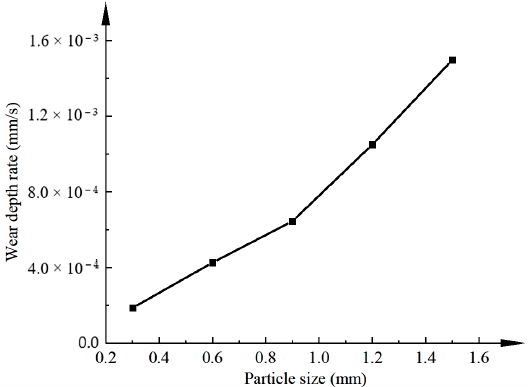
Figure 19. Depth of wear rate as a function of particle size.